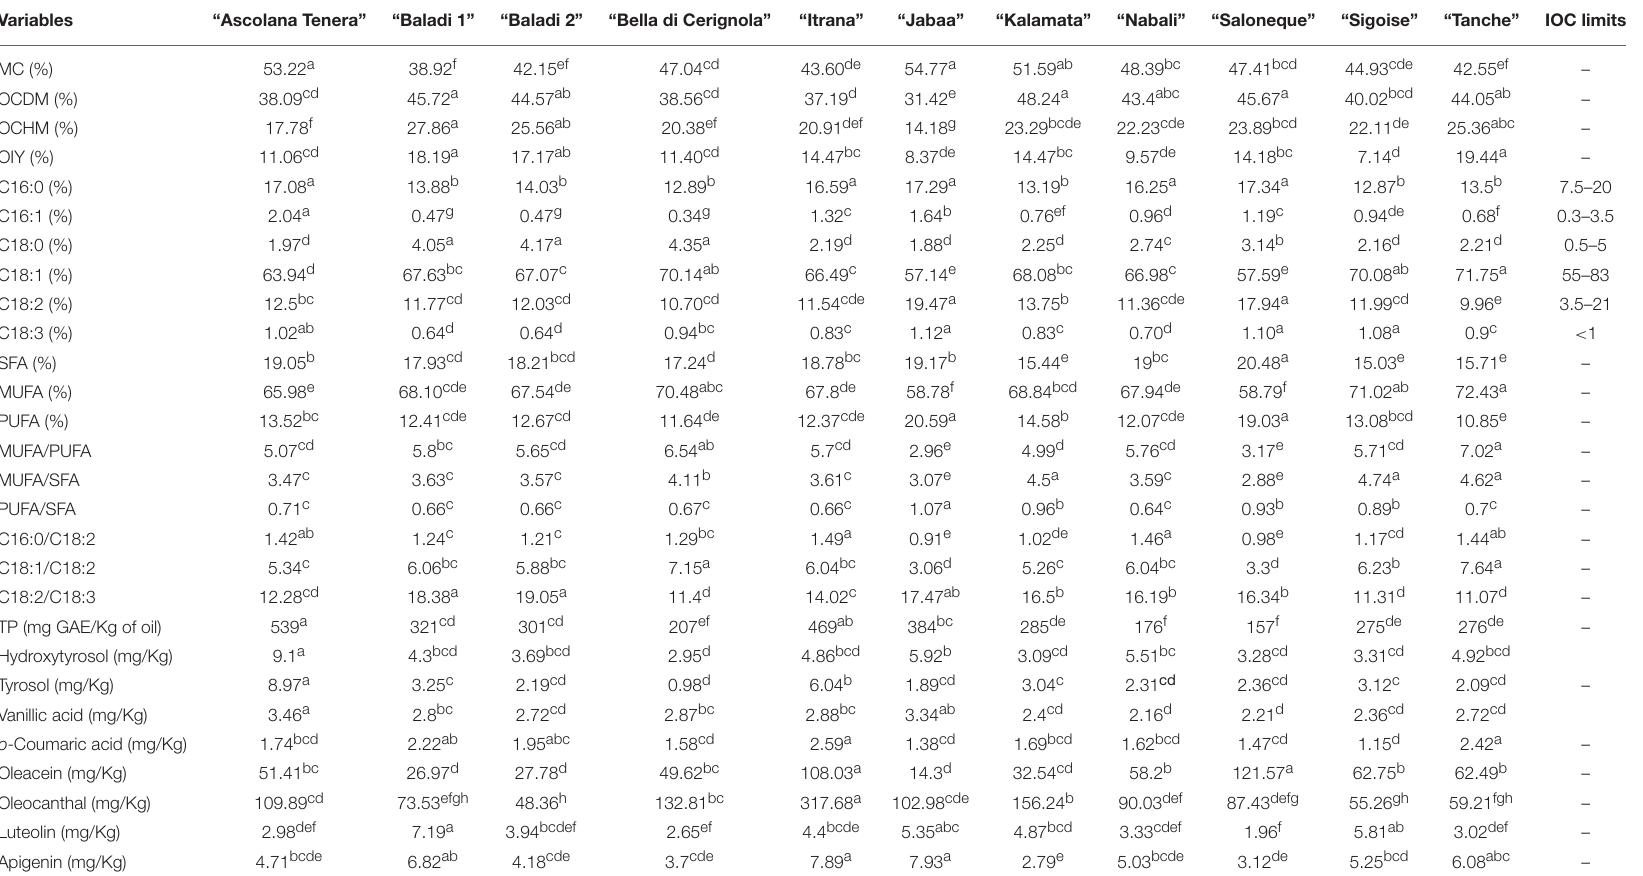
TABLE 3 | OC, fatty acids and phenolic compounds traits variability among the studied varieties cultivated in Lebanon.